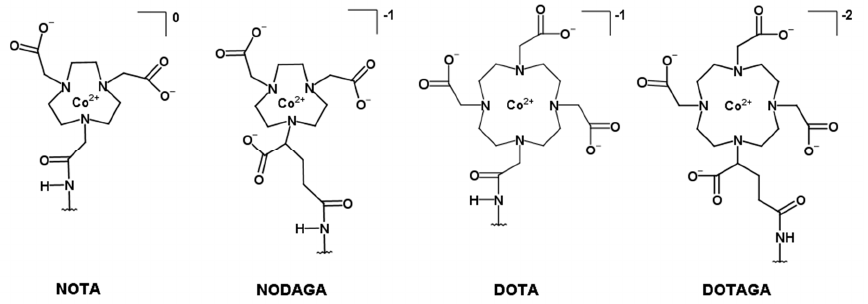
Figure 1. Structural overview of the macrocyclic chelators conjugated to the C-terminus of the HER3- targeting affibody molecule (HE) 3 -Z 08698 via a C-terminal cysteine (further denoted (HE) 3 -Z HER3 -X, with X = NOTA (1-(1,3-carboxypropyl)-4,7-carboxymethyl-1,4,7-triazacyclononane), NODAGA (1,4,7- triazacyclononane-N,N’,N’’-triacetic acid), DOTA (1,4,7,10-tetraazacyclododecane-1,4,7,10-tetraacetic acid), DOTAGA (1,4,7,10-tetraazacyclododecane, 1-(glutaric acid)-4,7,10-triacetic acid)). All new variants were labeled with 57 Co, with almost quantitative radiochemical yield determined by instant thin-layered liquid chromatography (ITLC) (Table 1, Figure S1). The labeled conjugates were stable in PBS and in human serum determined by ITLC. [ 68 Ga]Ga-(HE) 3 -Z HER3 - NODAGA was labeled with high radiochemical yield (89 ± 1%, determined by ITLC) and radiochemical purity exceeding 98% (ITLC) after purification with size-exclusion chromatography.